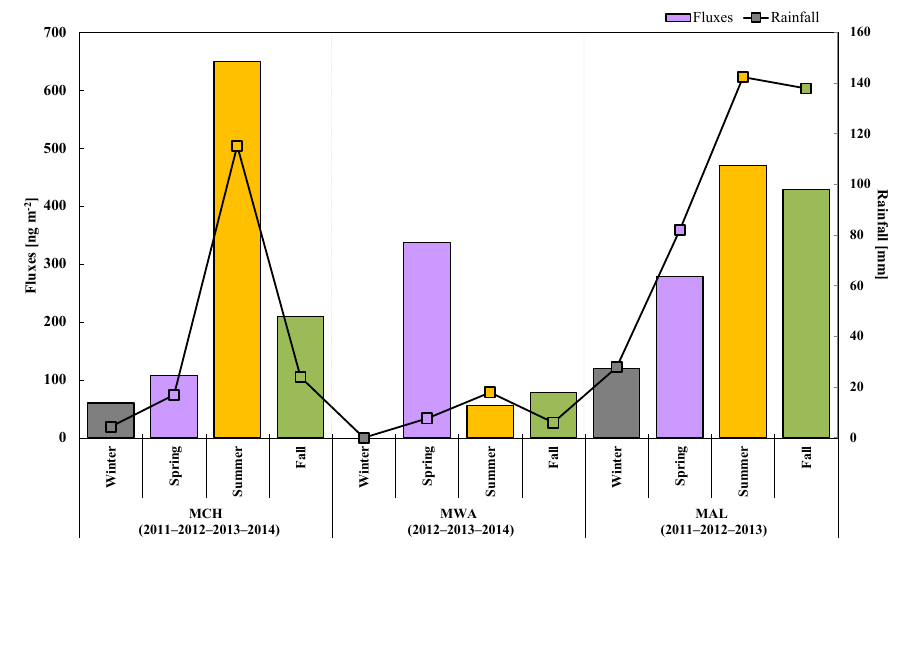
Figure 8. Seasonal mean values distribution of sampling-weighted (by 15-day reference) fluxes and rainfall at the three Chinese GMOS sites from 2011 to